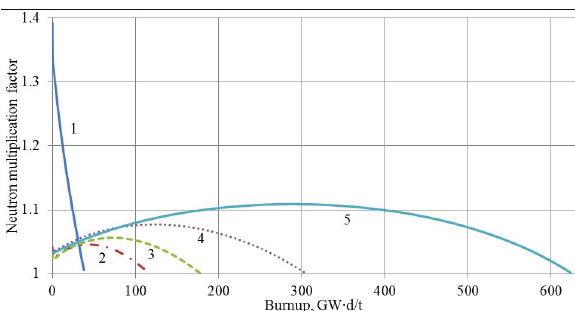
Figure 4. The effect of protactinium on the neutron multipli- cation factor in the process of fuel burning: 1) conventional uranium fuel (4.4% of 235 U + 95.6% of 238 U); 2) fuel composi- tion containing 11% of 235 U + 83% of 238 U + 6% 231 Pa; 3) fuel composition containing 16% of 235 U + 74% of 238 U + 10% of 231 Pa; 4) fuel composition containing 26% of 235 U + 54% of 238 U + 20% of 231 Pa; 5) complete substitution of 238 U for 231 Pa (44% of 235 U + 56% of 231 Pa).